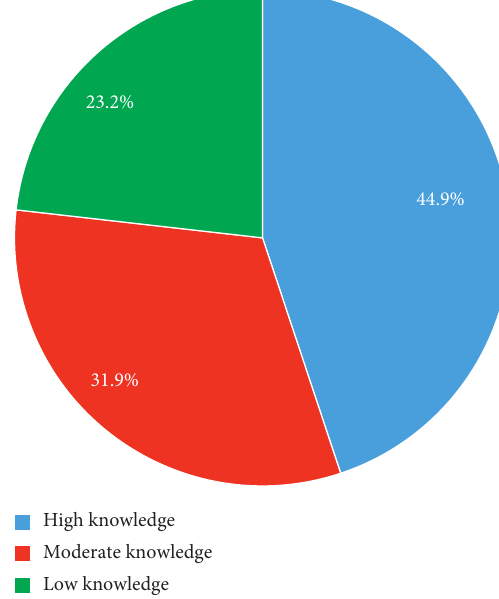
Figure 1: Nutritional knowledge of pregnant adolescents.